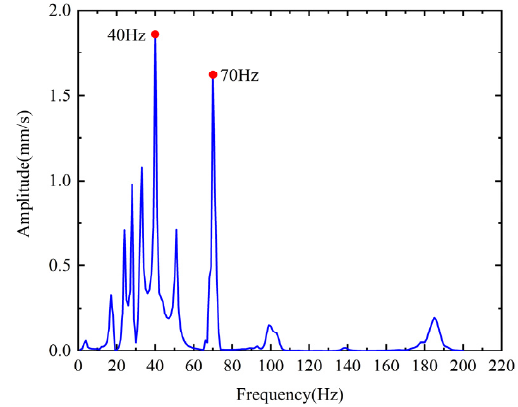
Figure 11. Horizontal vibration characteristic curve .